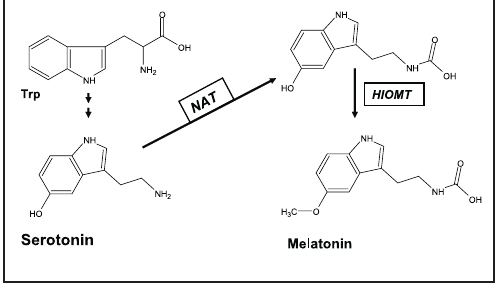
Fig. 2. Synthesis of melatonin. NAT = arylalcylamine N-acetyltransferase, HIOMT = hydroxyindole-